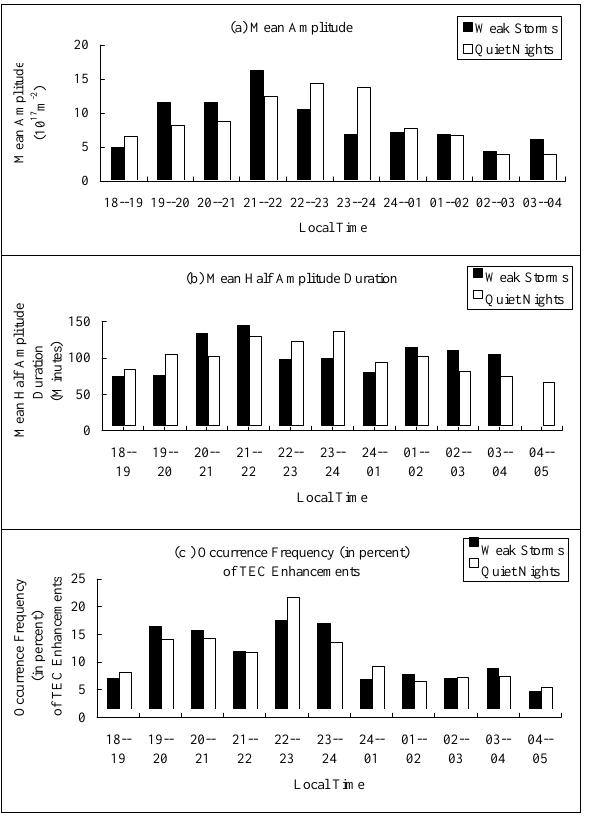
Fig. 6. The solar activity variations of (a) mean amplitude (b) mean half-amplitude and (c) the occurrence frequency (in percent) of TEC enhancement during major storms (bold curves), weak storms (solid curves) and those of quiet nights (dashed curves). The numbers of major storms are given in brackets beside the points for each solar flux group. The vertical bars represent the standard